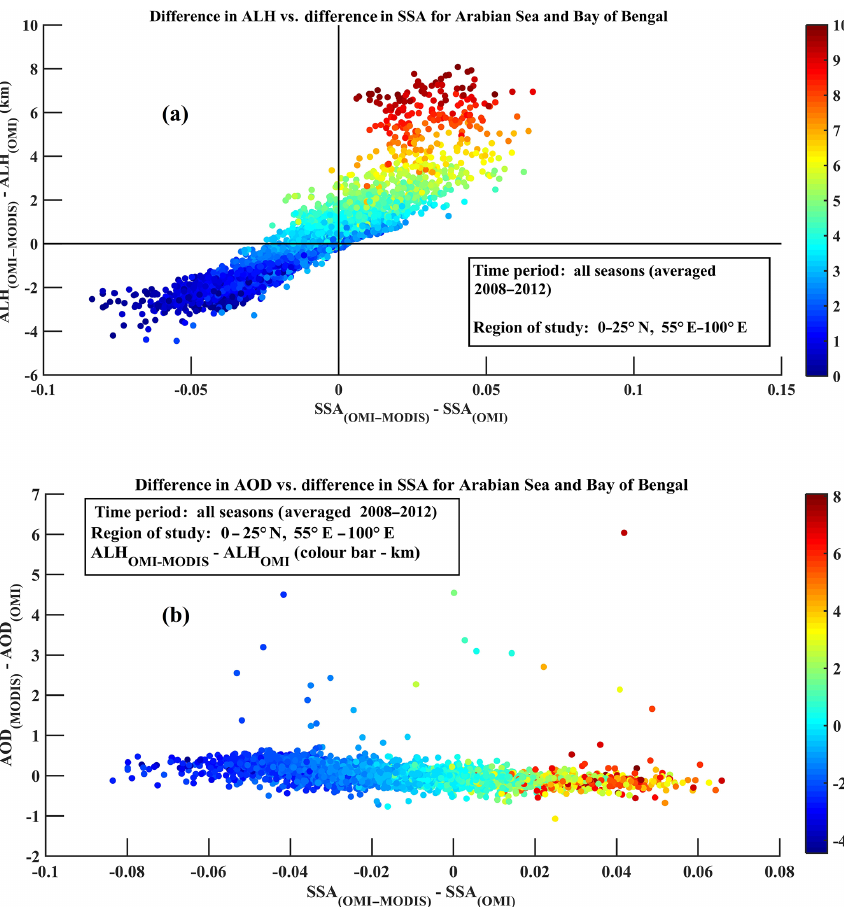
Figure 6. (a) The difference in the aerosol layer height (ALH, in kilometres) between OMI–MODIS and OMI vs. the difference in SSA over the Arabian Sea and the Bay of Bengal. The colour bar represents the ALH estimated by the OMI–MODIS algorithm (in kilometres). At lower heights (dark blue circles) estimated by OMI–MODIS, OMI overestimated SSA when the ALH was overestimated and vice versa at higher heights (dark red circles) estimated by OMI–MODIS. (b) The difference in the AOD (AOD MODIS –AOD OMI ) was plotted against the difference in SSA (SSA OMI–MODIS –SSA OMI ). An inverse relationship was observed. The colour bar represents the difference in ALH (in kilometres) between OMI–MODIS and